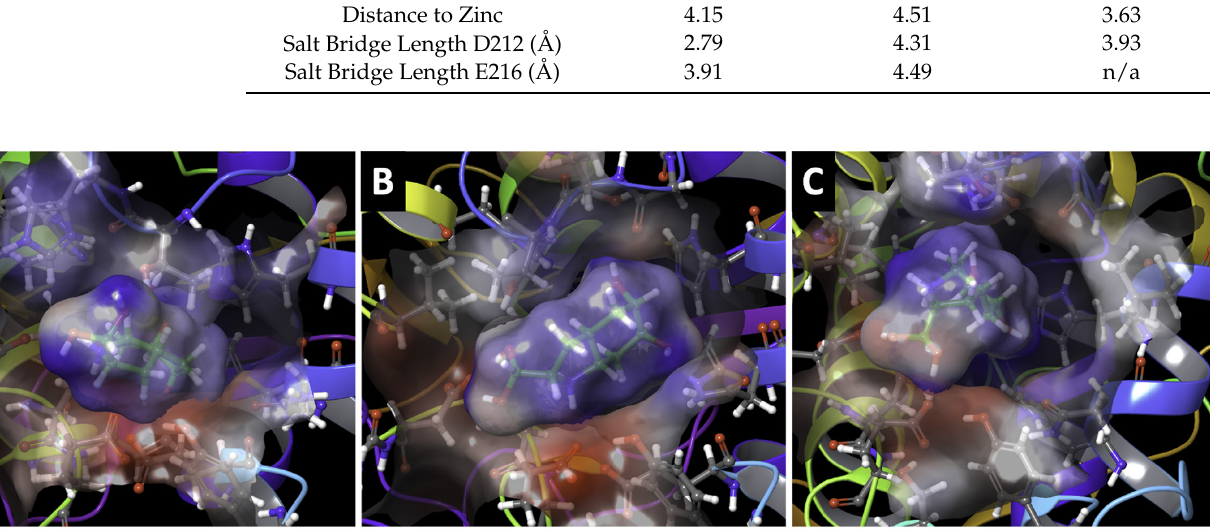
Figure 8. Molecular docking of DHICA to Tyrp1 ( A ), D308N ( B ), and R326H ( C ). Each docking result has DHICA within two water molecules of zinc with the hydroxyl groups on the aromatic ring oriented towards the active site. Structural images indicate that the partial positive of the NH 2 group of DHICA is oriented between the partial negative COO − side chains of D212 and E216. Docking experiments suggest as the severity of the mutation increases, DHICA is less tightly bound to the active site.